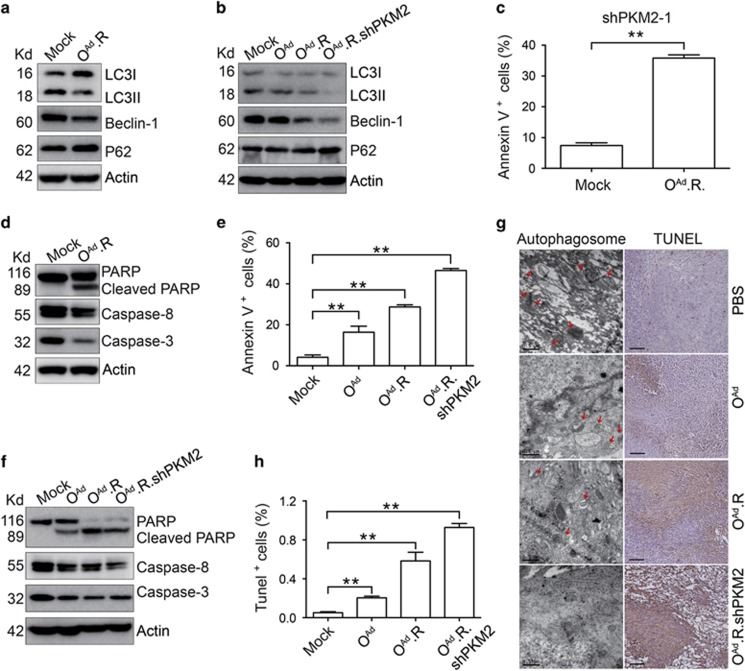
OAd.R.shPKM2 promotes apoptosis and inhibits autophagy in PANC-1 cells. (a) Western blot detection of the protein expression levels of the LC3-I/II ratio, Beclin-1 and p62 in PANC-1-shPKM2 cells treated with OAd.R at an MOI of 10 for 2 days. (b) Western blot detection of the LC3-I/II ratio, Beclin-1 and p62 in oncolytic adenovirus-infected PANC-1 cells at an MOI of 10 for 2 days. (c) Apoptosis was evaluated in PANC-1-shPKM2 cells treated with OAd.R at an MOI of 10 for 2 days using annexin V/PI staining. (d) Western blot detection of caspase-8, caspase-3 and PARP in PANC-1-shPKM2 cells treated with OAd.R at an MOI of 10 for 2 days. (e) Apoptosis was evaluated in oncolytic adenovirus-infected PANC-1 cells using annexin V/PI staining. (f) Western blot detection of caspase-8, caspase-3 and PARP in oncolytic adenovirus-infected PANC-1 cells. Cells were infected with the indicated oncolytic adenoviruses at an MOI of 10 for 2 days. (g) Representative images of TUNEL staining (scale bar, 200 μm; right panel) and electron microscopy (scale bar, 500 nm; left panel) of the tumor sections from each group. The red arrows indicate the autophagosome. (h) Quantification of the TUNEL staining results observed in g. Actin was used as a loading control in a, b, d and f. All experiments were repeated three times, and the bars represent the mean±S.D. (n=3). **P<0.01